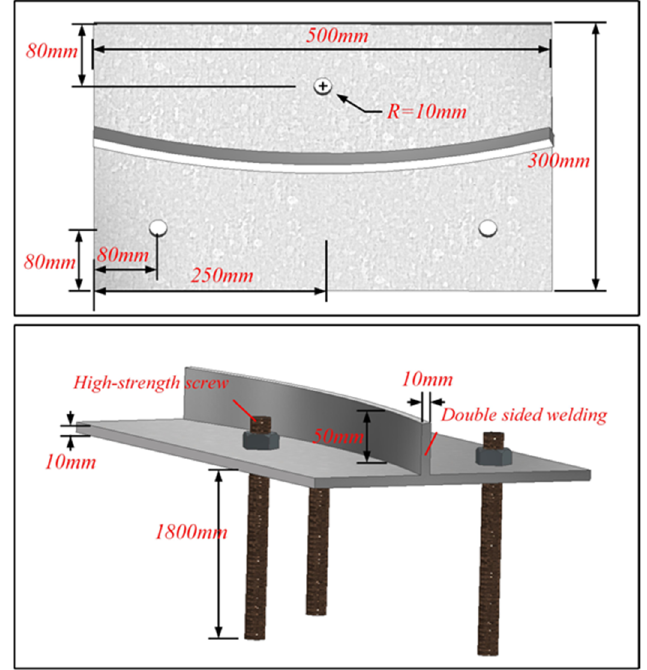
Figure 3. Dimensional drawing of the deviator.